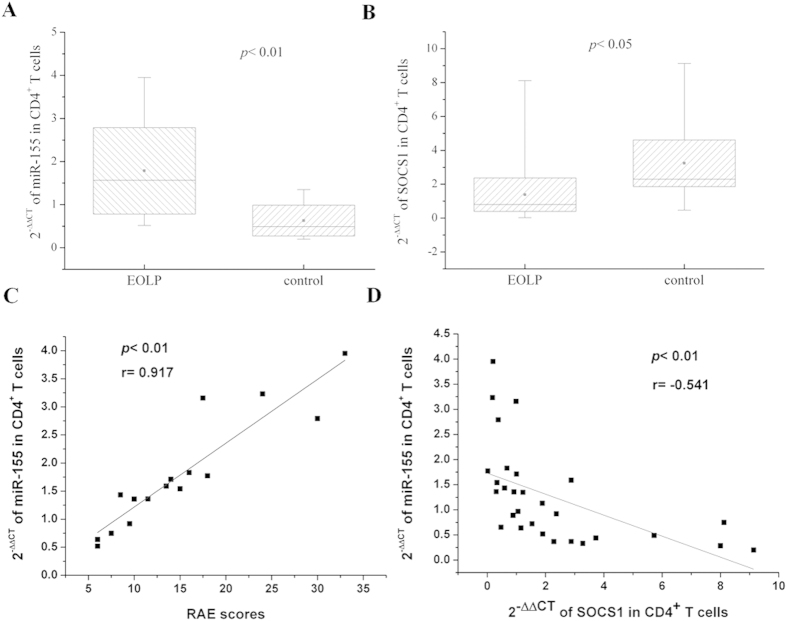
The expression of miR-155 and SOCS1 mRNA in CD4+ T cells from EOLP patients.(A,B) 2−ΔΔCT was used to calculate the relative expression of miR-155 and SOCS1 mRNA. The significant differences between EOLP group and the healthy controls were tested by independent-samples t test, and results are represented as box plots. (C,D) Pearson’s correlation test was performed, and statistical significance as well as the correlation coefficient is shown. Each dot plot represents a subject, and the correlation is fitted into a straight line.